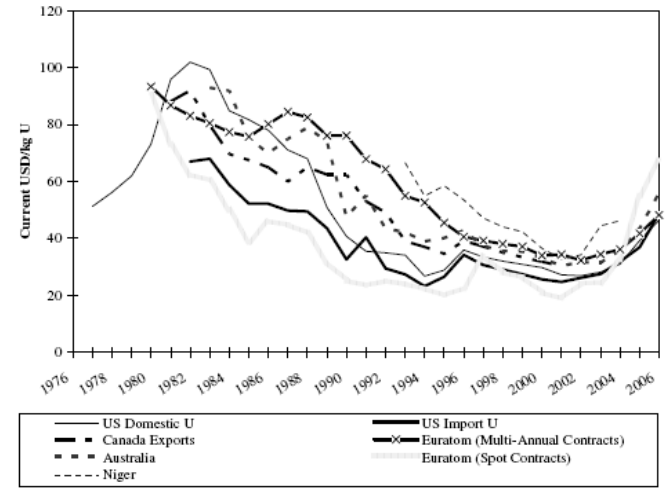
Figure 18. Uranium prices 1976–2007. © 2008 OECD, reproduced from [96] with permission.